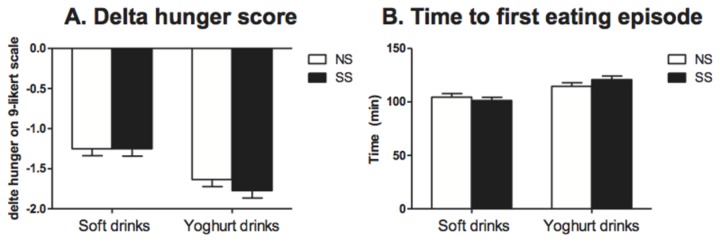
Satiety scores in the conditioning period (A) The average delta scores of the hunger ratings in the conditioning period (hunger rating after consumption minus hunger rating before consumption) for the NS (◻) and SS (◼) soft drinks and the yoghurt drinks: there was a significant main effect of drink type (p<0.0001): the yoghurt drinks reduced hunger more than the soft drinks.(B) The average time until subjects ate their first item after consumption in the conditioning period for NS (◻) and SS (◼) soft drinks and the yoghurt drinks: there was a significant main effect of drink type (p<0.0001): after the yoghurt drinks the average time was longer than after the soft drinks. Values are means ± SEMs (n=40). Analyses were performed by means of ANOVA (mixed model procedure).